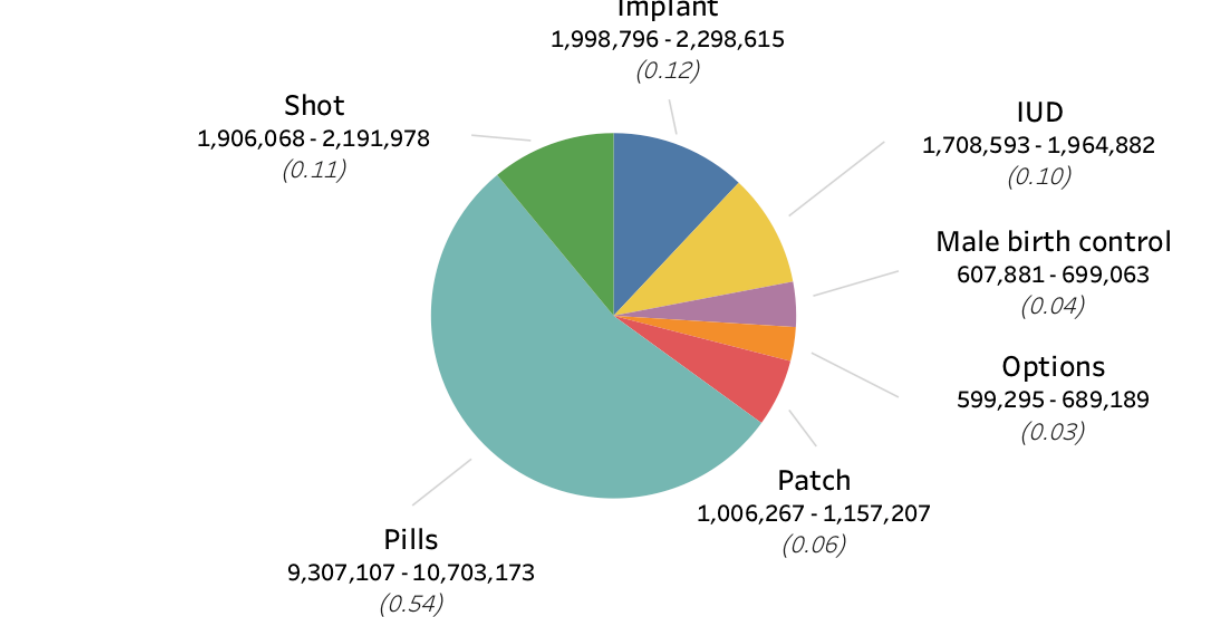
Figure 4. Estimated total search volume (range) and relative search volume (within parentheses) for birth control in the United States in 2017. IUD: intrauterine